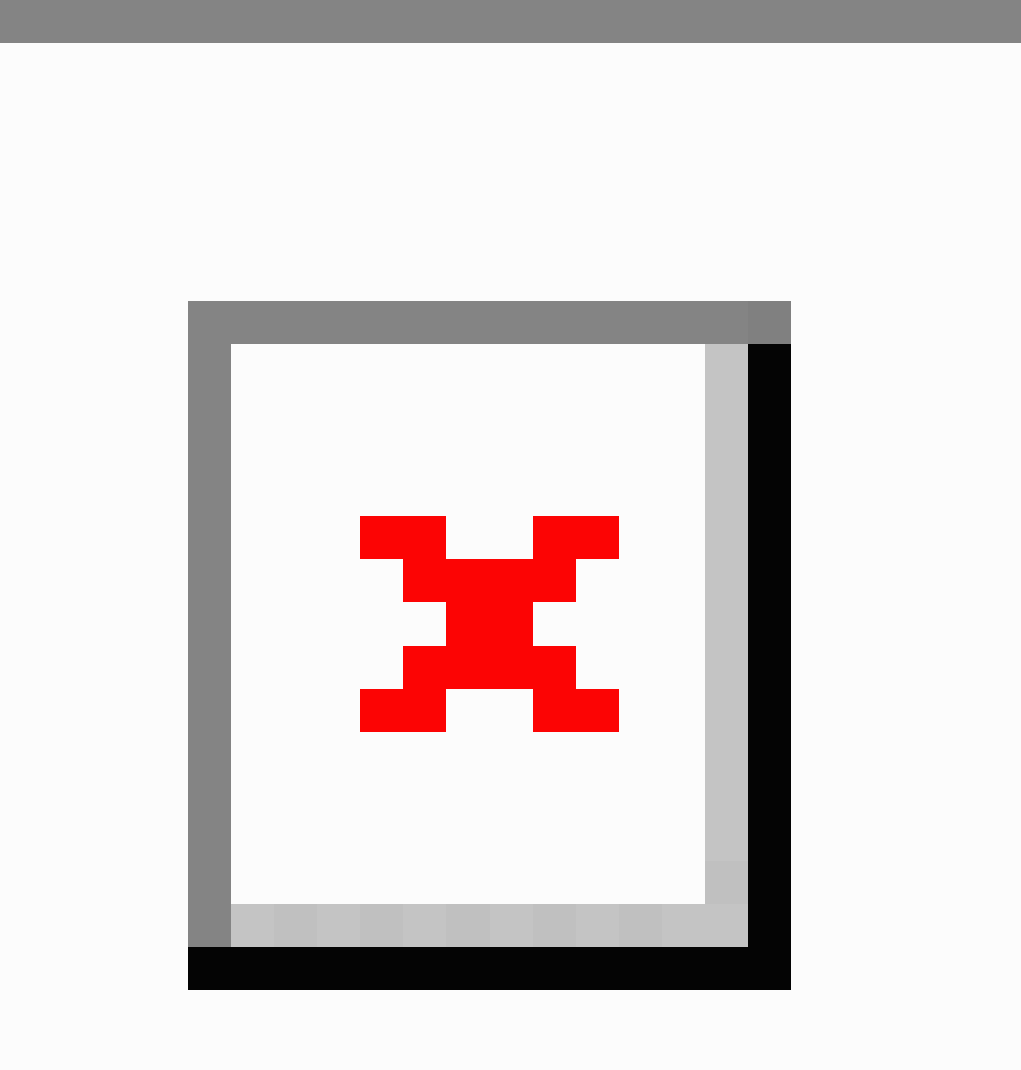
Figure 2. Example of an image-based dietary record in the Diet Bytes and Baby Bumps study, consisting of image, fiducial marker, and audio description of the food and drink